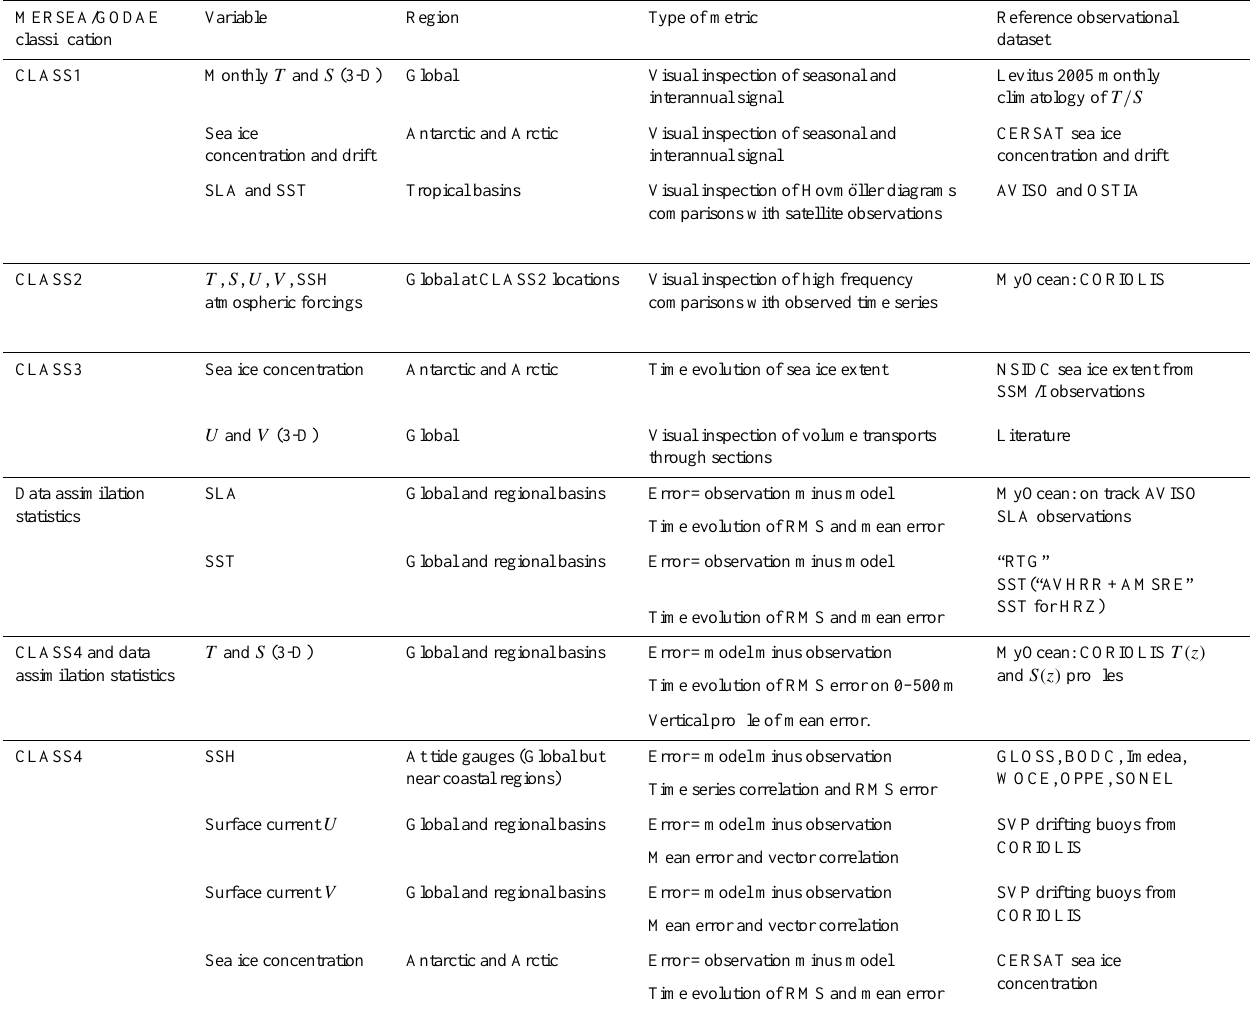
Table 3. Types of metrics used for calibration/validation during